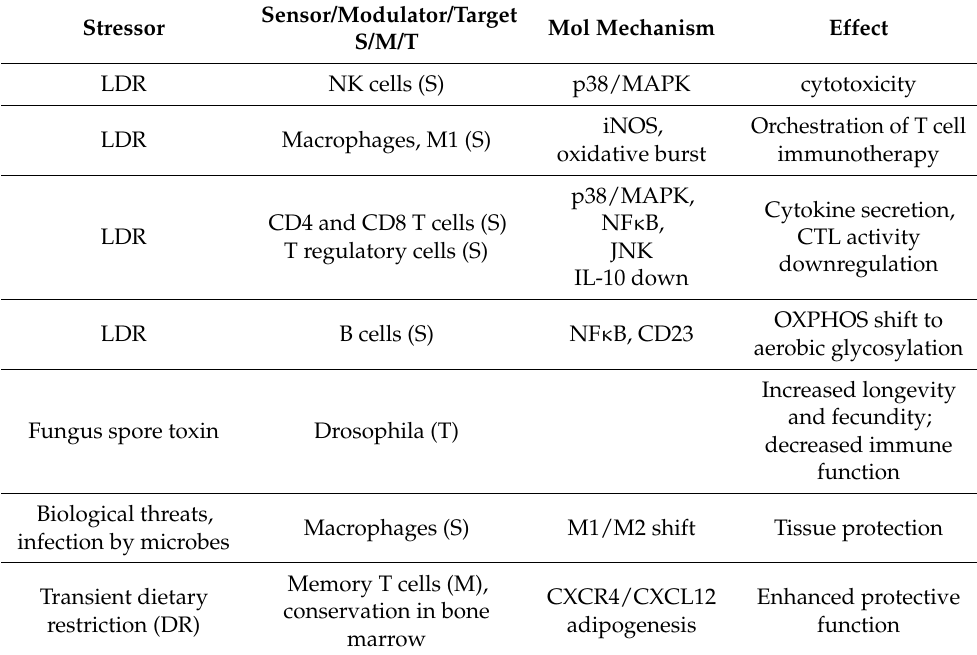
Table 3. Hormetic effects in the immune